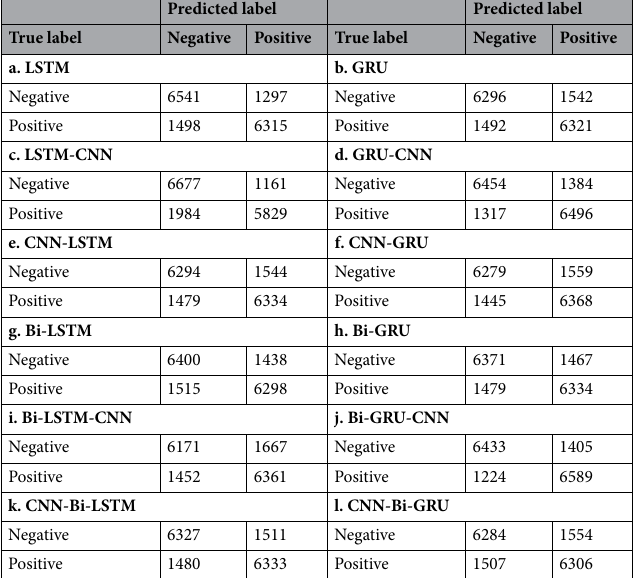
Table 13. Confusion matrices of the BRAD